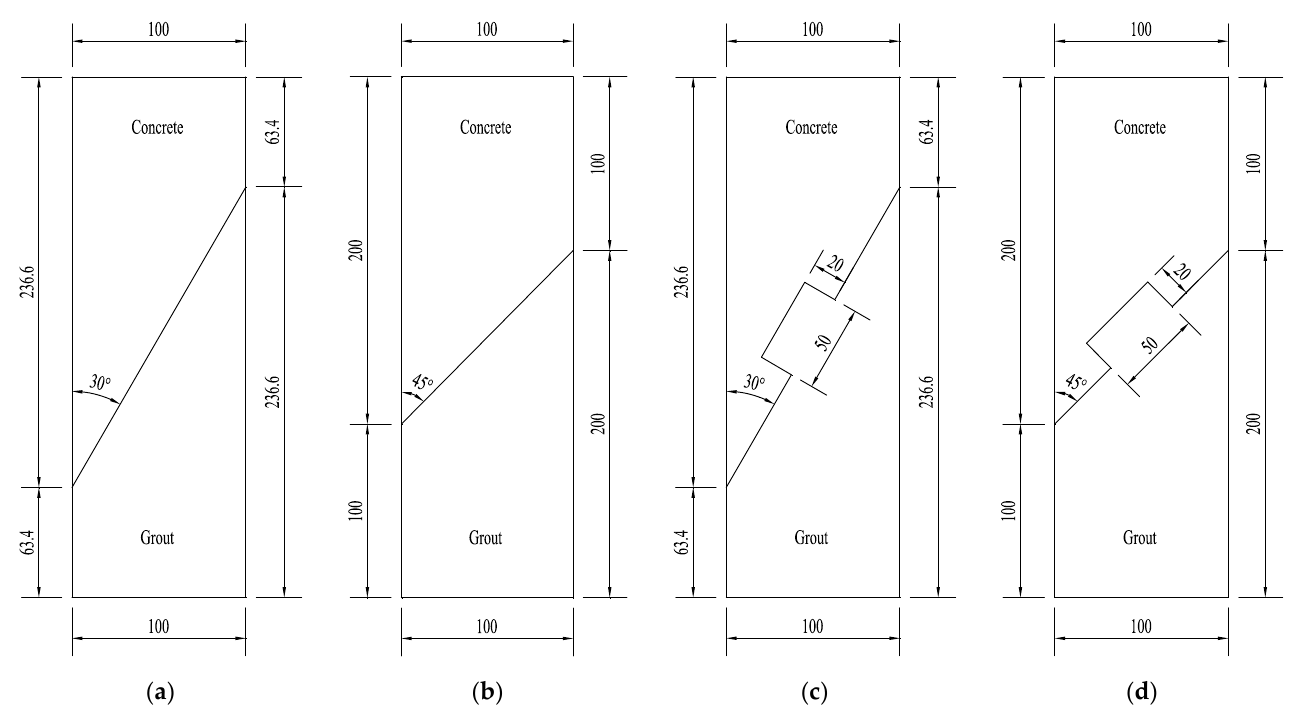
Figure 2. Size and configuration of the slant shear specimens (in mm): ( a ) α = 30°, no shear key; ( b ) α = 45°, no shear key; ( c ) α = 30°, with shear key; ( d ) α = 45°, with shear key. Table 2. Parameters of the specimens for the slant shear test.